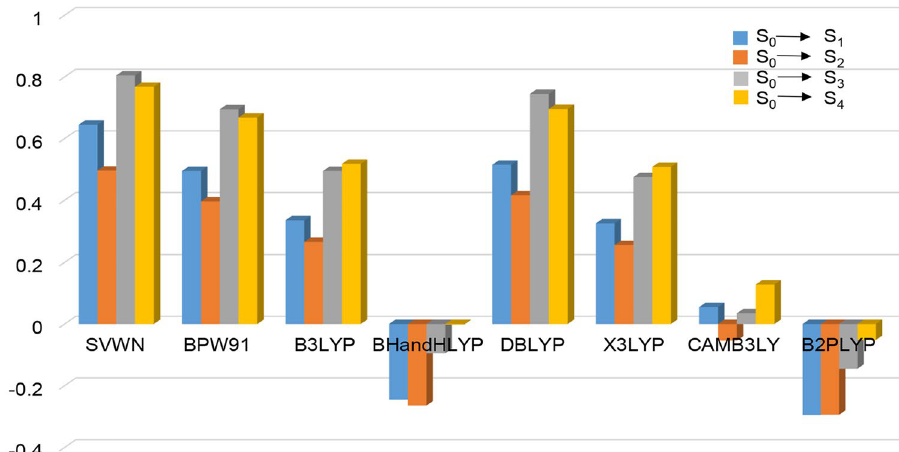
Figure 2. Errors for the transition energies of the first four excited states between CCSD and the eight different DFT methods for Zn 2 S 2.